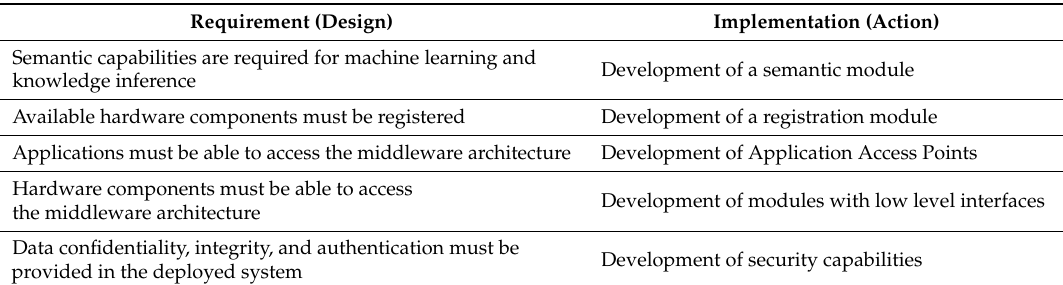
Table 3. Usage of requirements for implementation